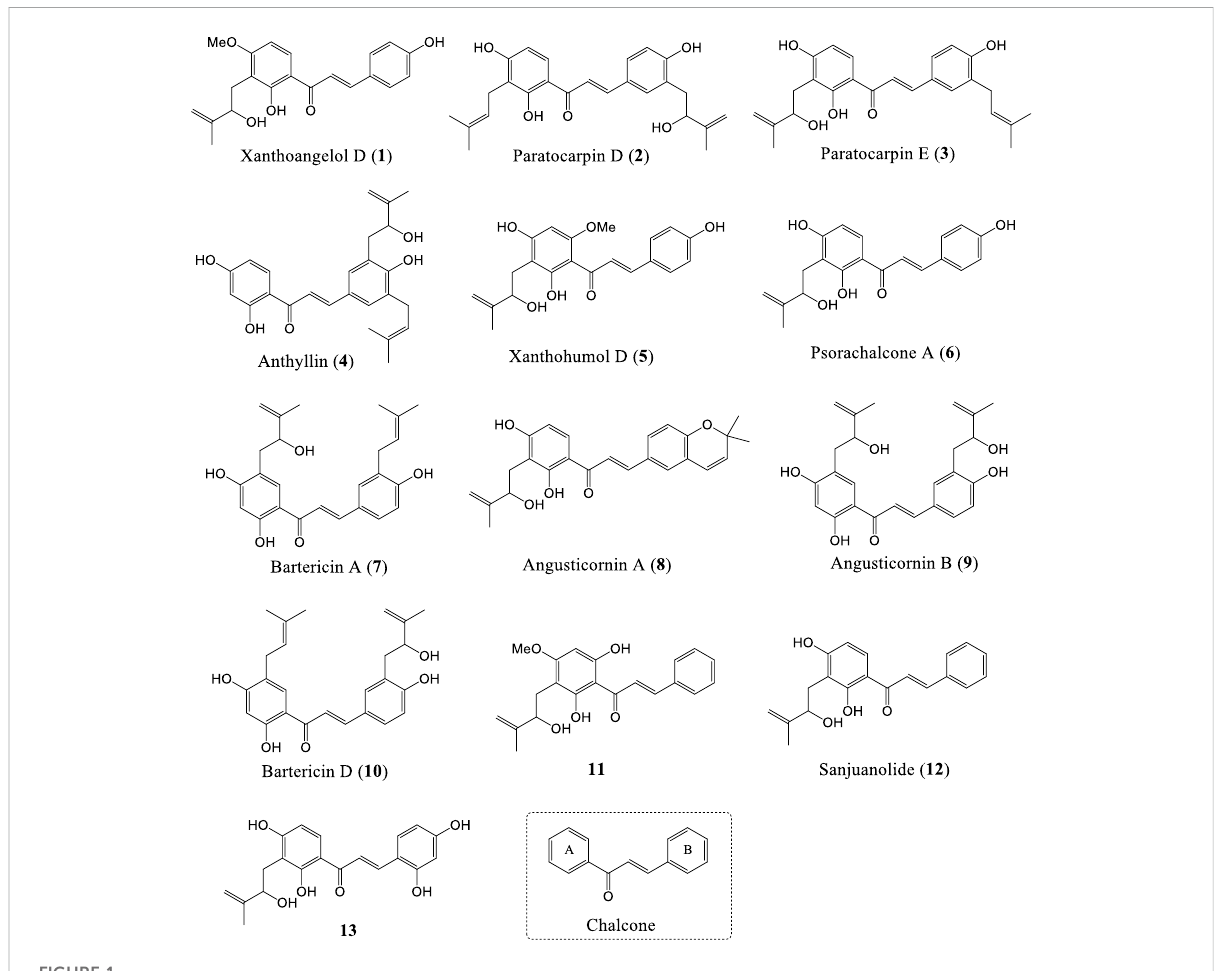
FIGURE 1 Structures of natural chalcones and a chalcone-type compound bearing HMB group ( 1 - 13 ) and